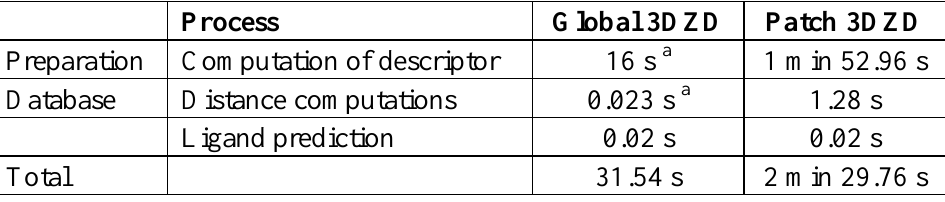
Table 4. Computation time determined on the Kahraman